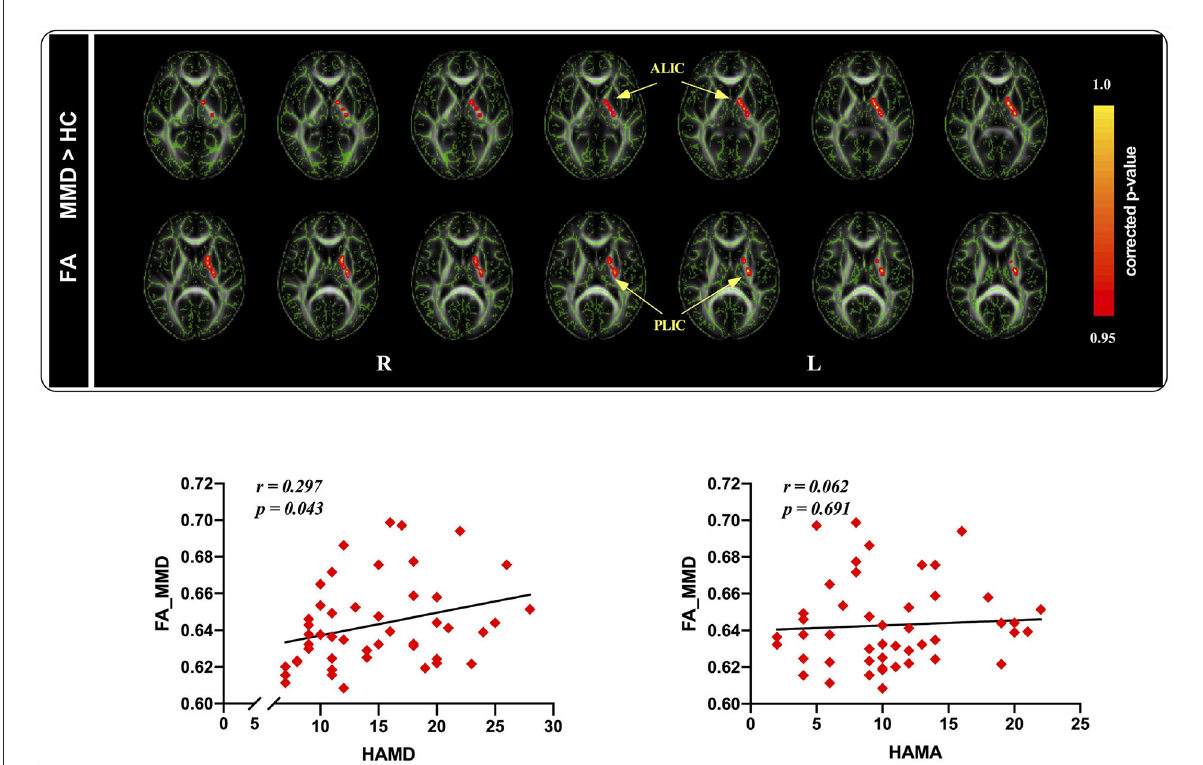
FIGURE2 Tract-based spatial statistics maps are shown the FA differences between the two groups and the correlation between FA and HAMD as well as HAMA ratings in MMD patients. (Top): Red represents regions with significantly increased FA in MMD patients, compared with HCs. (Bottom): FA values were significantly correlated with HAMD ratings, whereas not related to HAMA ratings in MDD patients. FA, fractional anisotropy; HAMD, hamilton depression; HAMA, hamilton anxiety; MMD, mild-to-moderate depression; HCs, healthy controls.